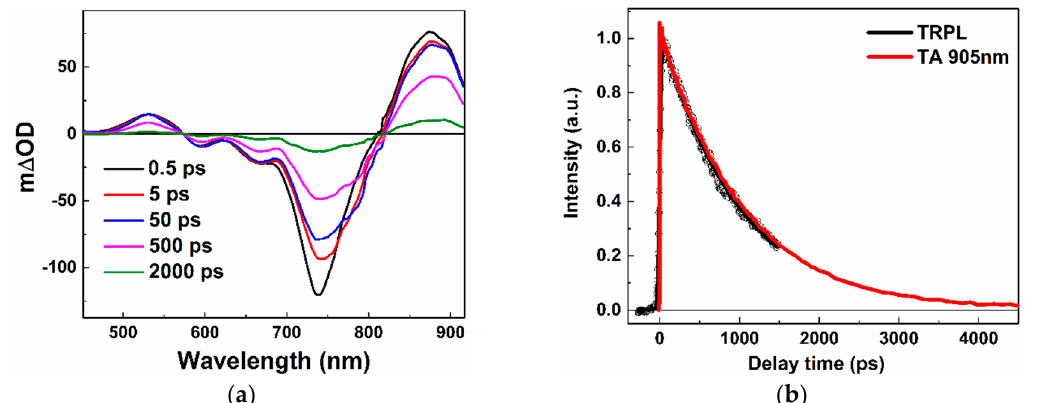
Figure 3. ( a ) Transient absorption spectra of Y6 solution at indicated delay times after photoexcitation at 700 nm with an excitation fluency of 2 × 10 15 photons cm − 2 . ( b ) Comparison of time-resolved photoluminescence (TRPL) and transient absorption (TA) kinetics in the Y6 solution.